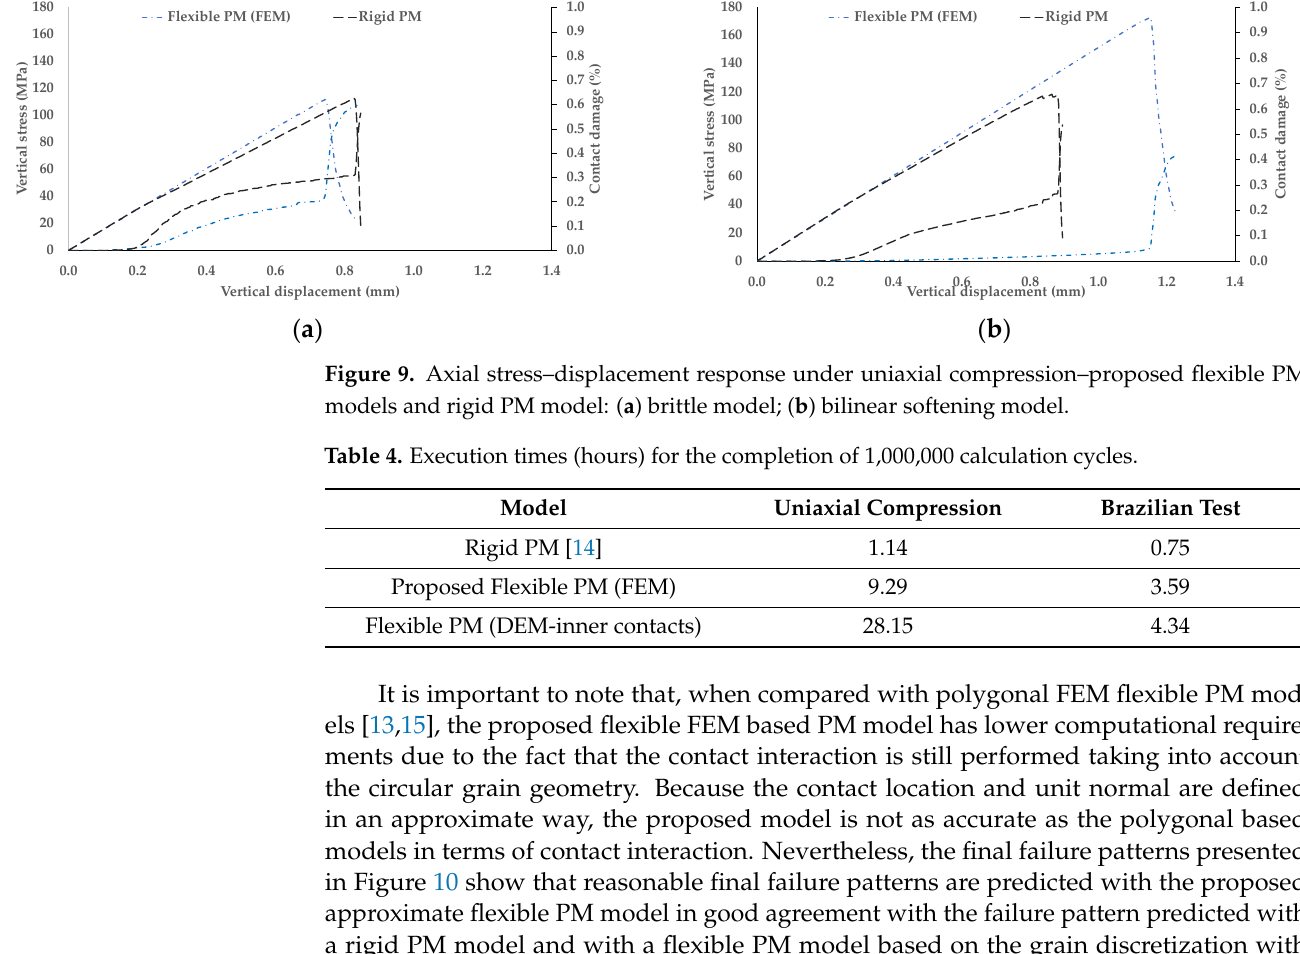
Figure 8. Axial stress–displacement response under uniaxial compression-proposed flexible PM models and DEM-inner contacts): ( a ) brittle model; ( b ) bilinear softening model.